Question: State the chart type depicted above.
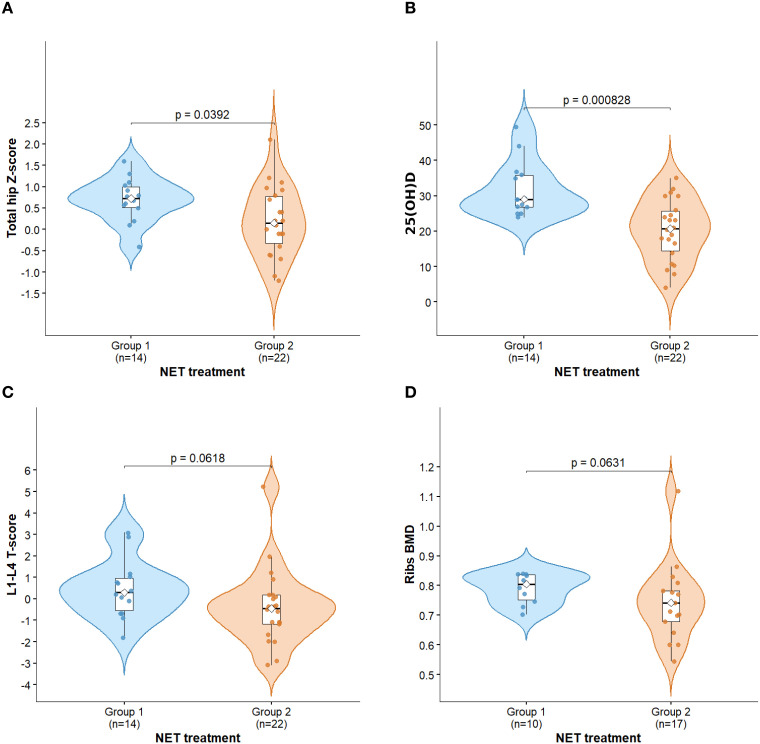
Answer: box